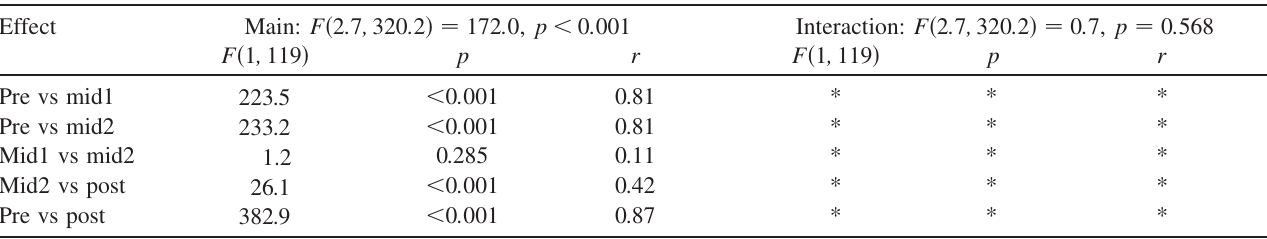
TABLE V. Repeated measure analysis of variance: mechanical advantage score. * indicates that the planned contrasts could not be